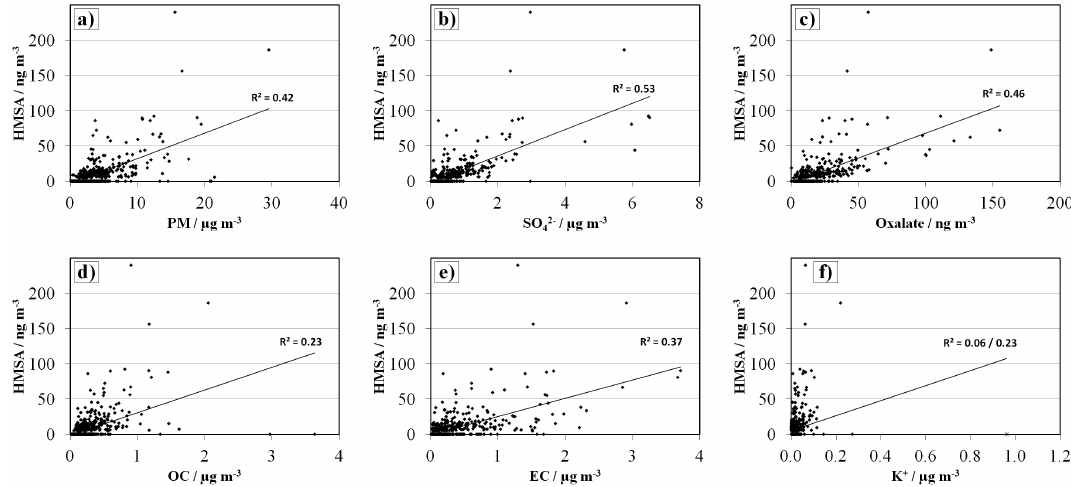
Fig. 5. Correlations of HMSA mass concentrations with (a) the respective PM mass concentration and (b–f) the mass concentrations of sulfate, oxalate, organic carbon, elemental carbon and potassium, respectively. In (f) , R 2 is given with and without the consideration of an outlier (0.96ngm − 3 K + ) . The charts comprise the complete data set (738 samples). See text for discussion.